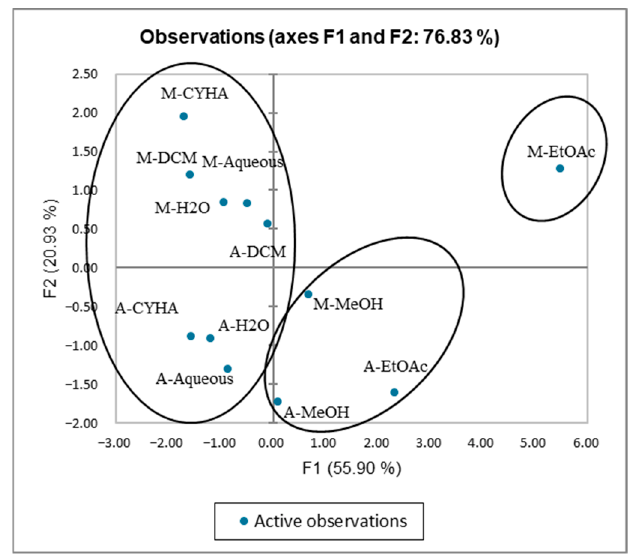
Figure 10. Principal Components analysis “loading plot” of (DPPH: Antioxidant activity) (TPC: total phenolic content) and biological activities (Alpha amylase: Antidiabetic activity); 15-LOX: Anti-in- flammatory activity); (HCT-116 and Caco-2: cytotoxic activity) and (AChE: anti-Alzheimer activity) of V. vinifera stem extracts.